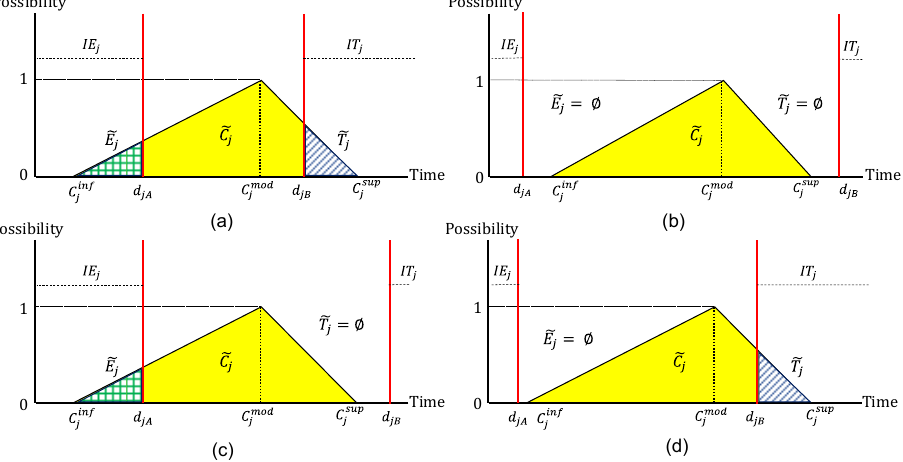
Figure 6. Cases of fuzzy tardiness and fuzzy earliness for each job j ( a ) tardiness or earliness; ( b ) no tardiness or earliness; ( c ) earliness; ( d ) tardiness.